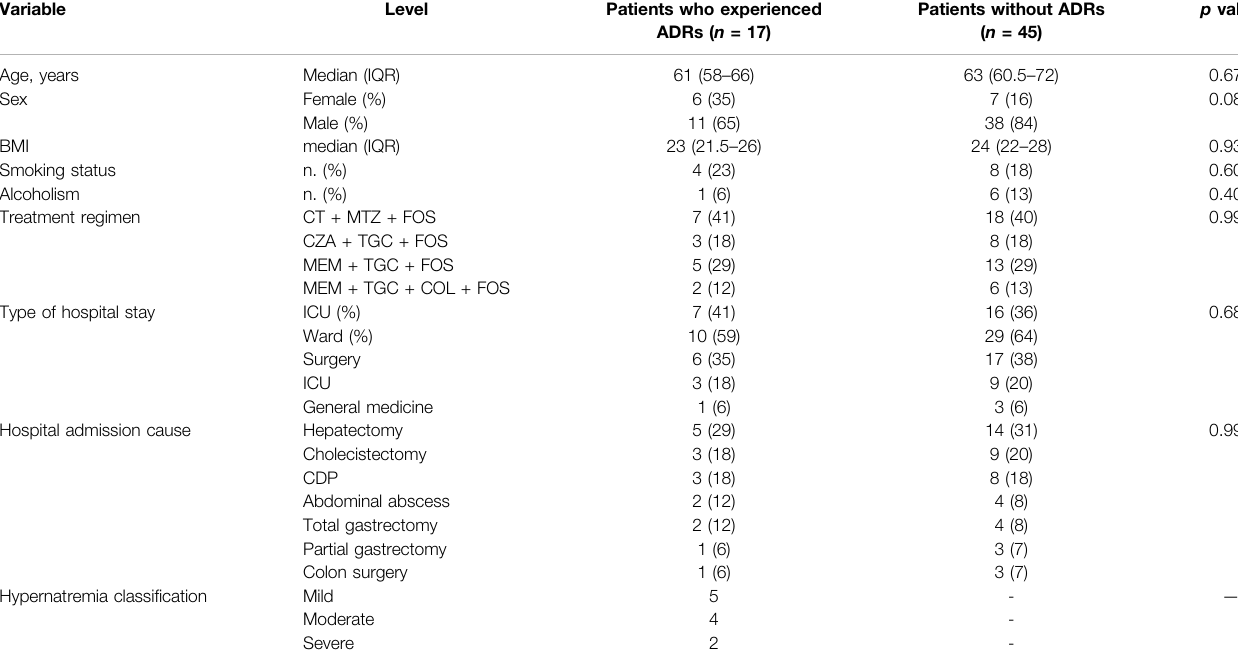
TABLE 2 | Main clinical and demographic characteristics of patients who had received fosfomycin.